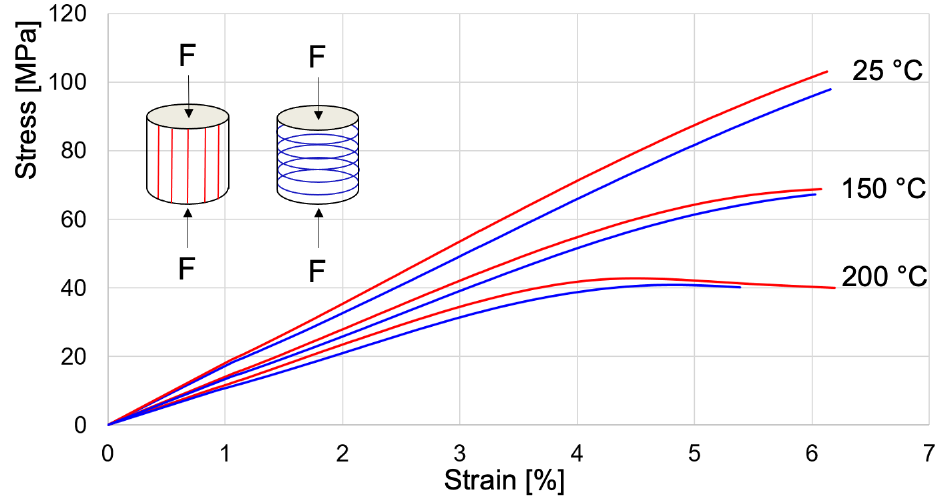
Figure 11. Compressive engineering stress-strain plot with different building orientations and testing temperatures of 3D printed ULTEM TM samples.